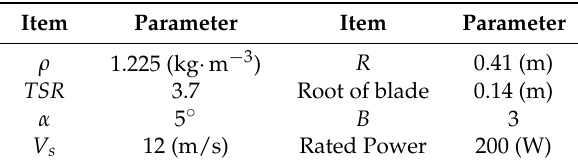
Table 2. The Geometry parameter of the blade.